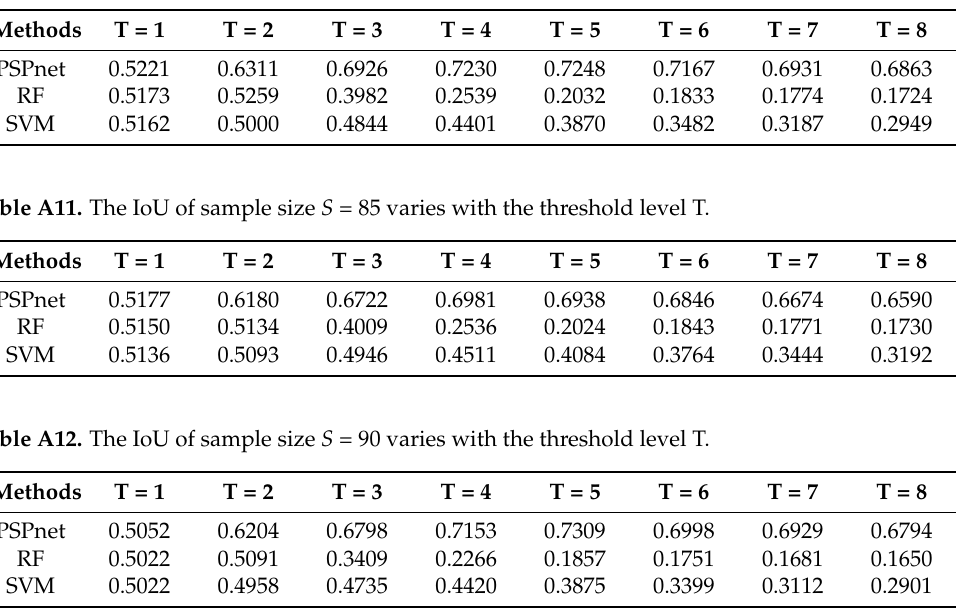
Table A10. The IoU of sample size S = 80 varies with the threshold level T.